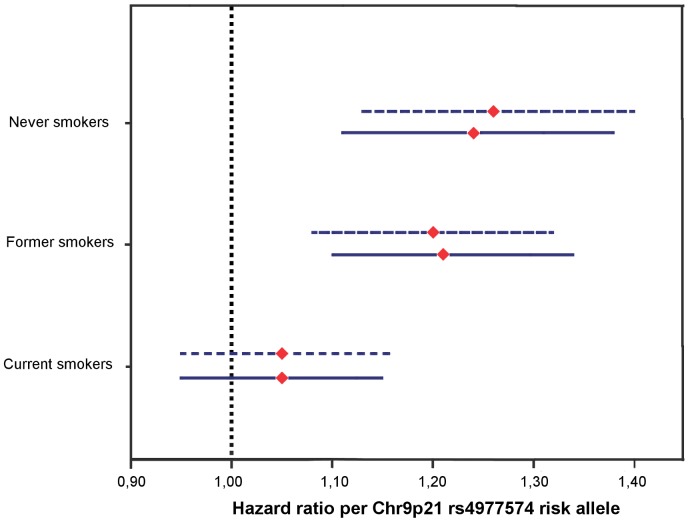
Risk of incident CAD by rs4977574 stratified by smoking status.Hazard ratios (HR) with 95% Confidence Interval per risk allele of rs4977574 in never (N = 9642) former (N  = 8300) and current (N = 7000) smokers respectively. Models adjusted for age and sex (dotted upper lines) and adjusted for covariates age, sex, smoking status, education, physical activity, systolic blood pressure, antihypertensive medication and BMI (continuous lower lines).